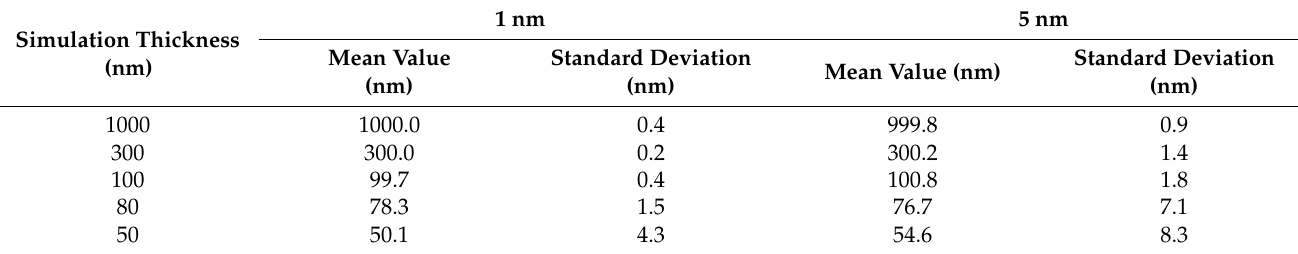
Table 1. Influences of the scanning step error on the measurements of films with different thicknesses.